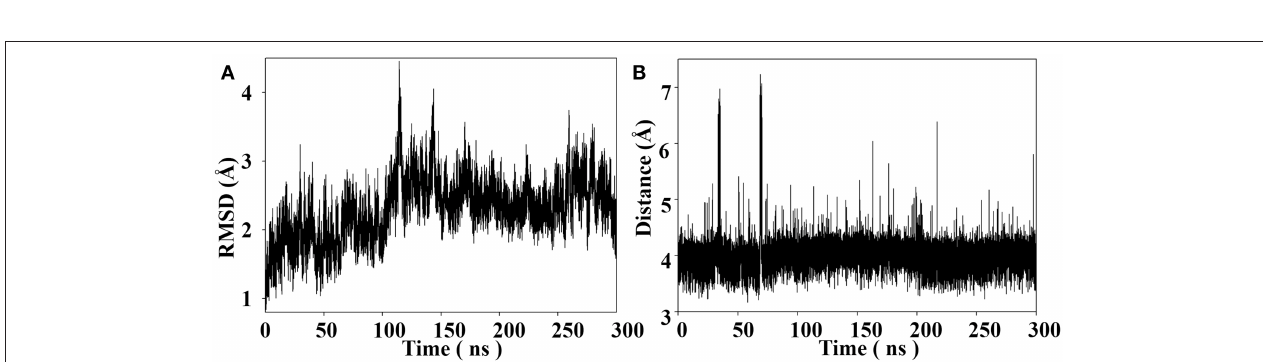
FIGURE 3 | The superimposed structures of the X-ray structure and the docked structure for tweezer included K214. The tweezer molecule and K214 are plotted using stick style, in which carbon atom is colored in yellow for X-ray tweezer, while blue for the structure after docking. (A) Top view of the superimposed structures, (B) side view of the structures.